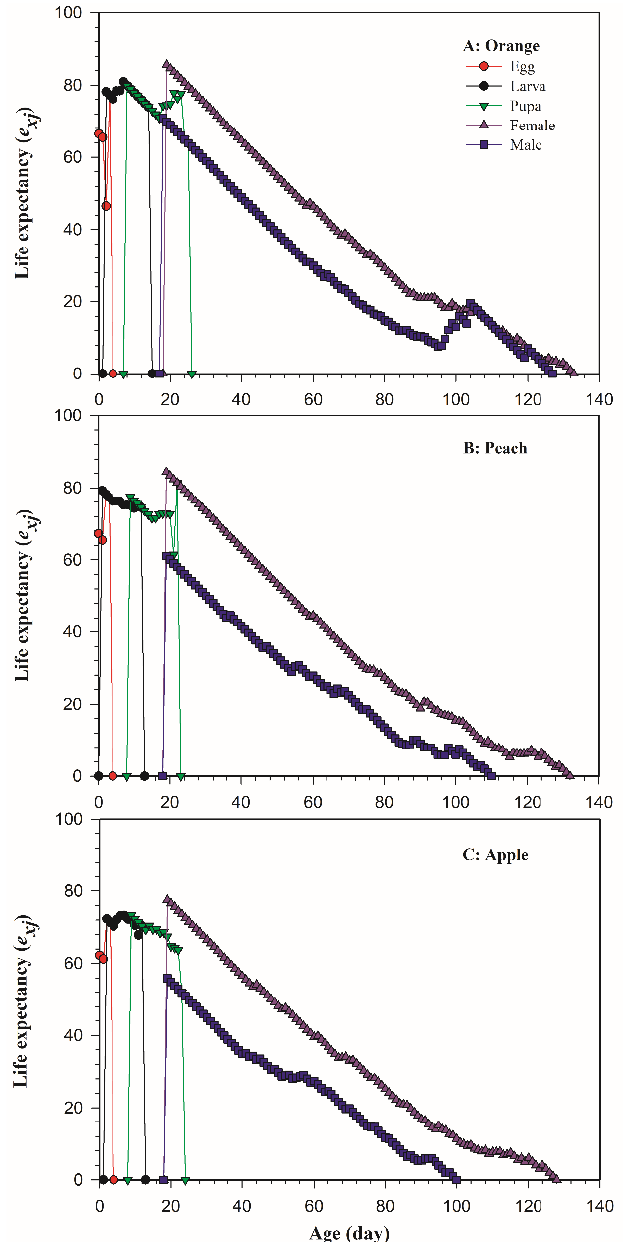
Figure 3. The age-stage life expectancy ( e xj ) of Bactrocera dorsalis on three host fruits: ( A ) orange; ( B ) peach; ( C ) apple.